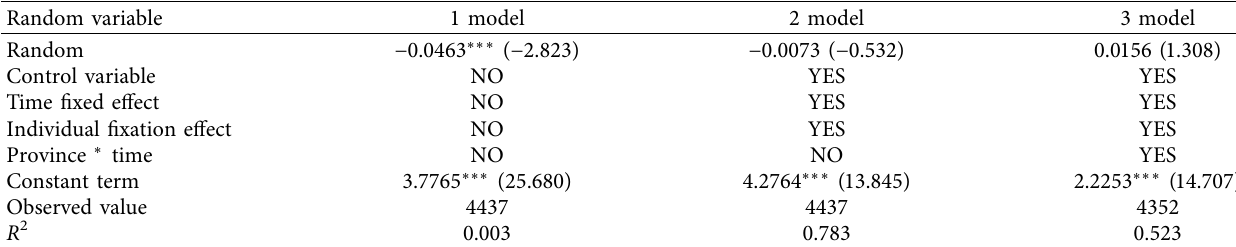
Table 6: Placebo test.